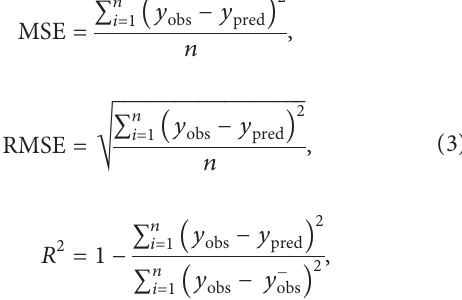
Figure 13: BPNN structure.